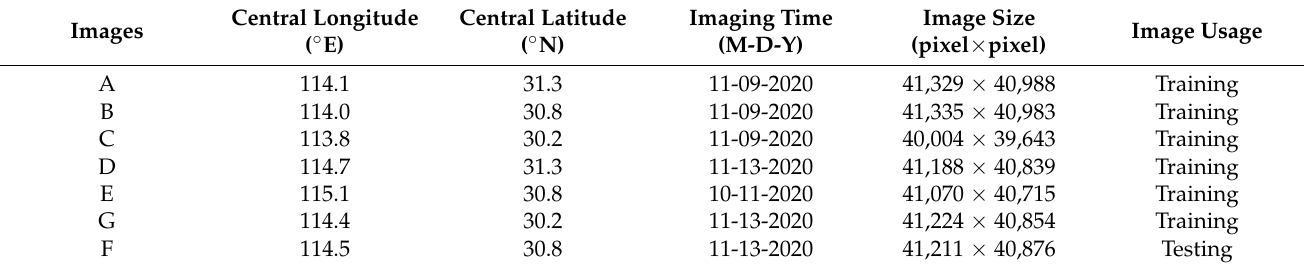
Figure 3. Flowchart of remote sensing image preprocessing. Table 3. Detailed information of the study data.